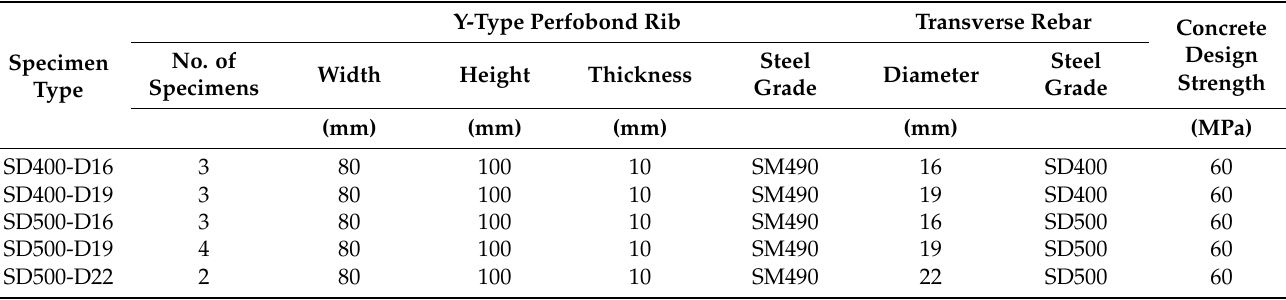
Table 2. Specimen design for additional push-out